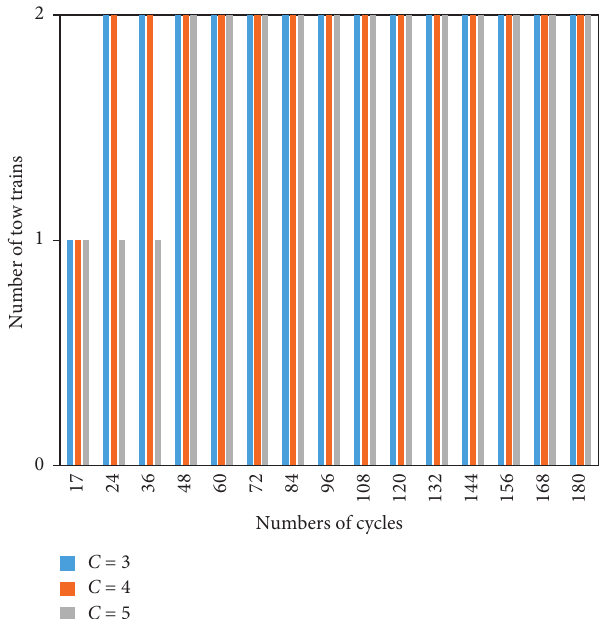
Figure 4: Number of vehicles in different capacities.